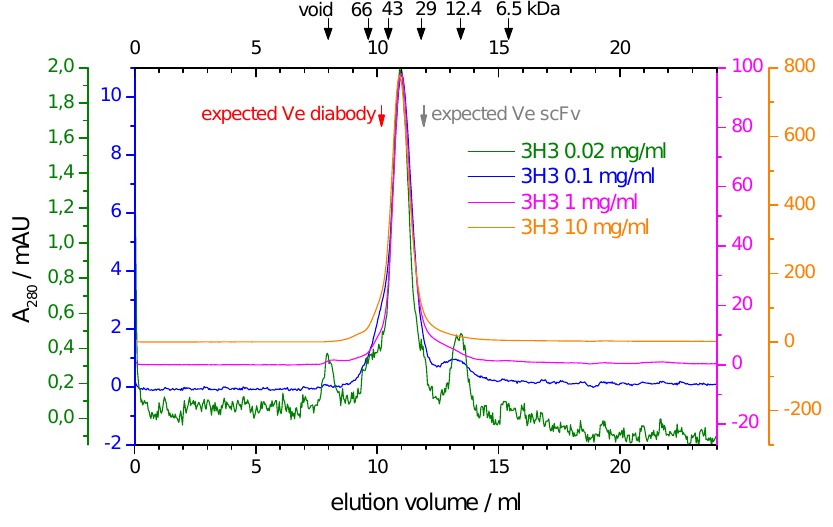
Figure 2. Analytical size exclusion chromatography of 3H3. A Superdex 75 10/300 column was equilibrated with 20 mM MES, pH 6.5, 500 mM NaCl. Four runs with 100 µ L of 3H3 at the indicated protein concentrations were performed. The absorbance at 280 nm (A 280 ) is shown with a separately scaled y -axis for each concentration so that the baselines are slightly offset and the maxima coincide, thus allowing accurate comparison of elution volumes and peak profiles. The elution volume of standard proteins in a dedicated calibration run is indicated by arrows at the top. The void volume was determined with ferritin (443 kDa). The expected elution volume (Ve) for the diabody (54kDa) and the scFv (27kDa) were calculated based on the calibration and are indicated with red and gray arrows,